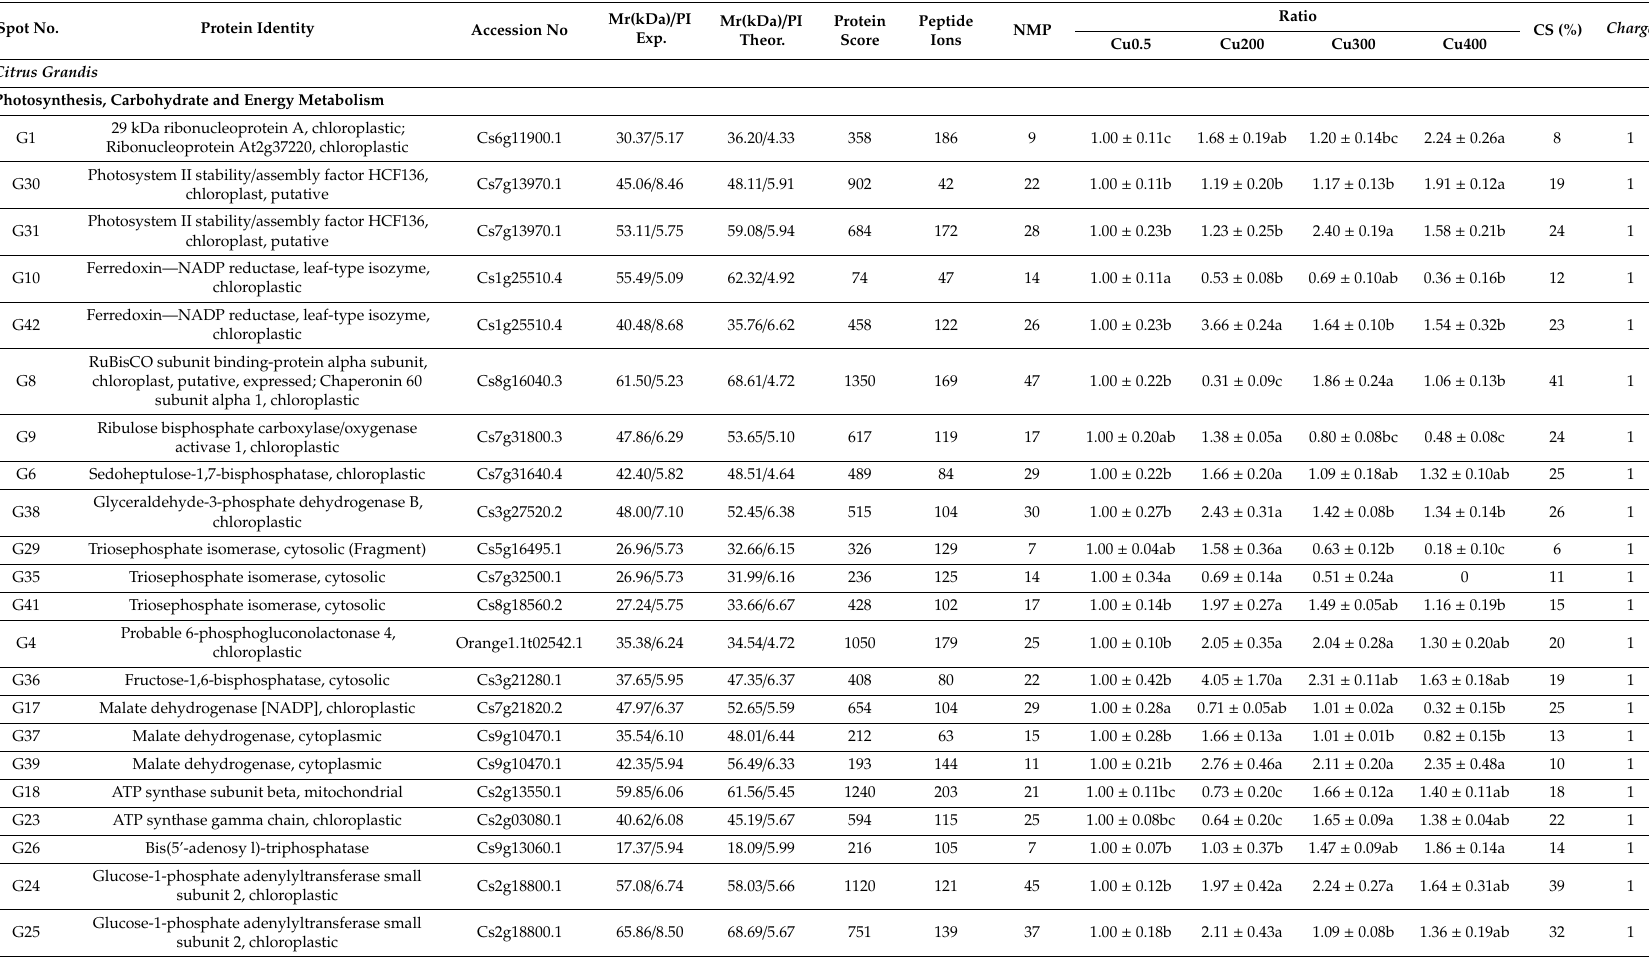
Table 2. Di ff erentially abundant protein (DAP) spots and their identification by MALDI-TOF / TOF-MS in 0.5 (control), 200 (Cu200), 300 (Cu300) or 400 (Cu400) Cu-treated Citrus grandis and C. sinensis